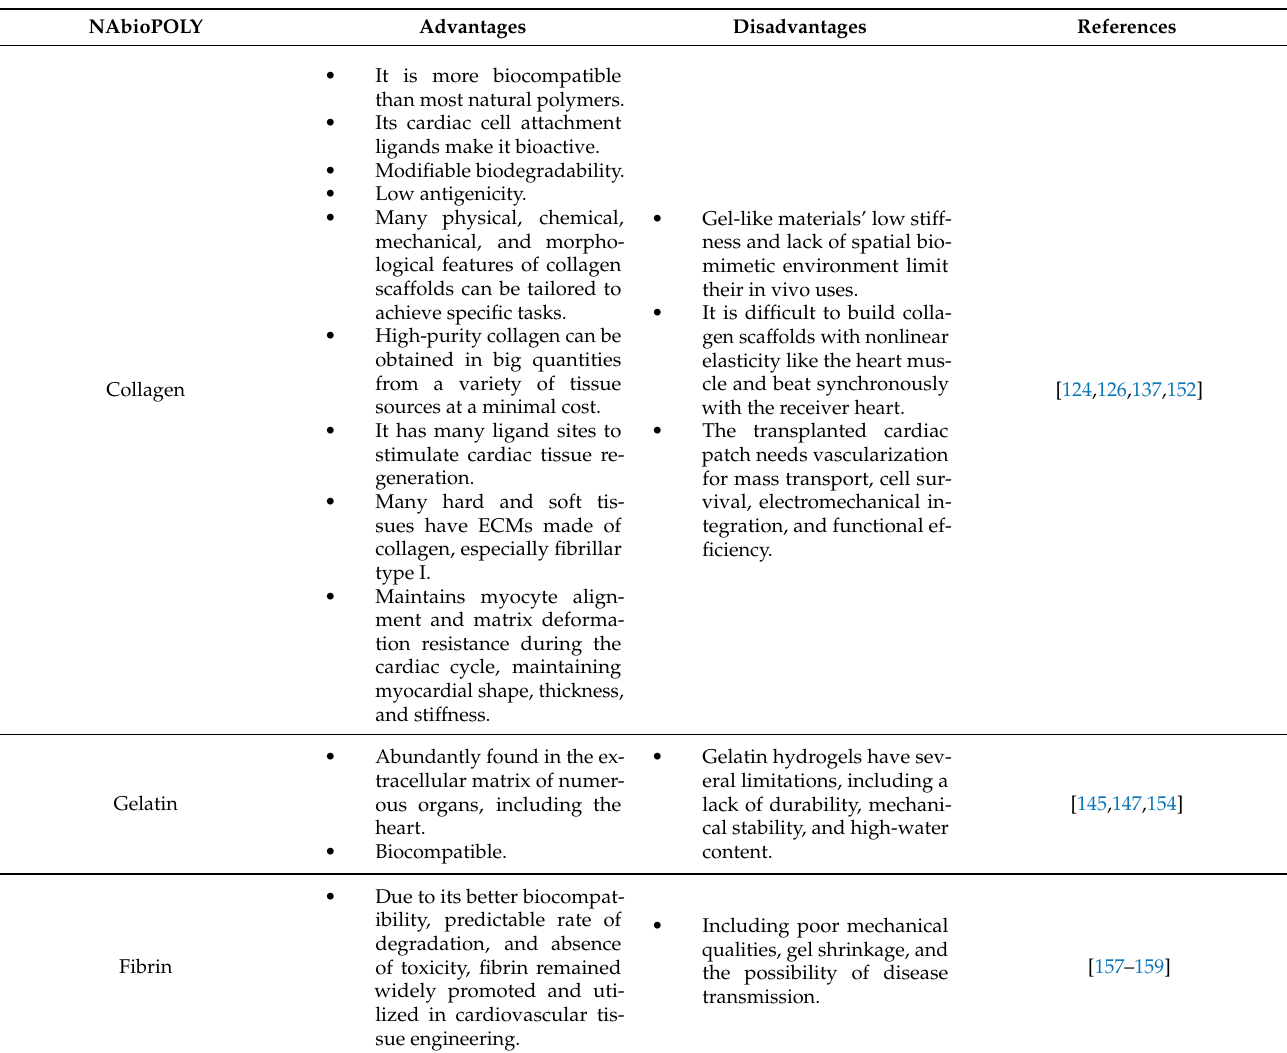
Table 8. Advantages and disadvantages of Natural biodegradable nanopolymers (NAbioPOLY) in cardiac tissue